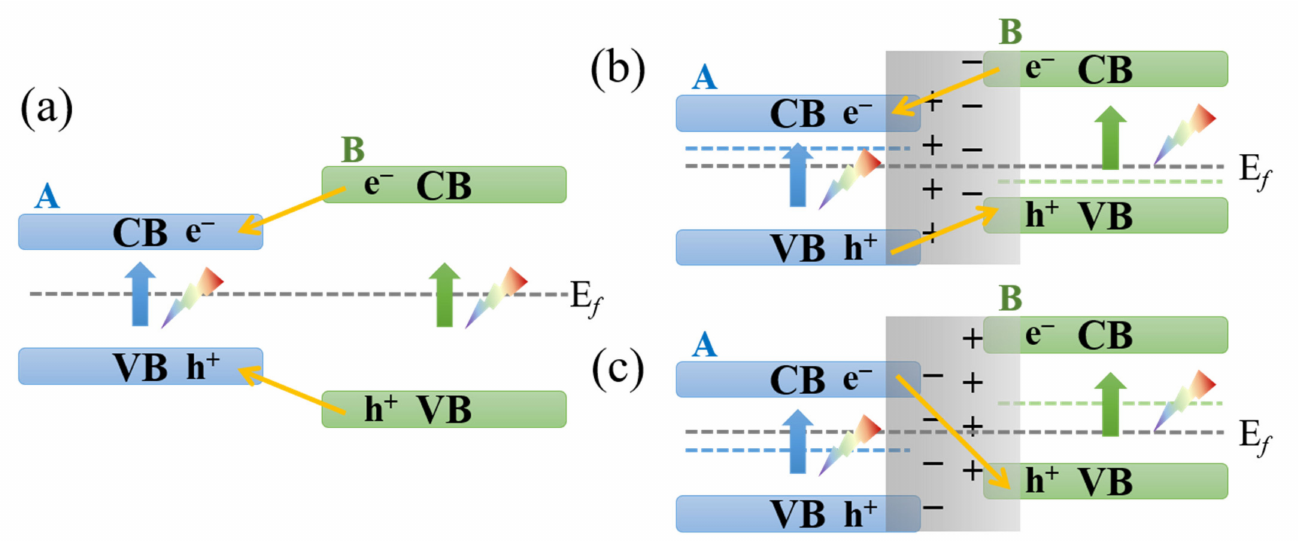
Figure 10. The illustration of semiconductor–semiconductor heterojunction type-1 ( a ) and type-2 ( b , c ), where A and B both represent semiconductors with different band